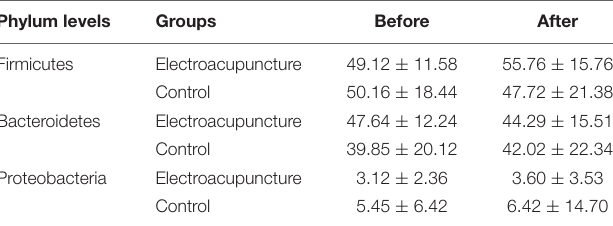
TABLE 4 | Comparison of Phylum level between two groups of patients before and after treatment (x ±